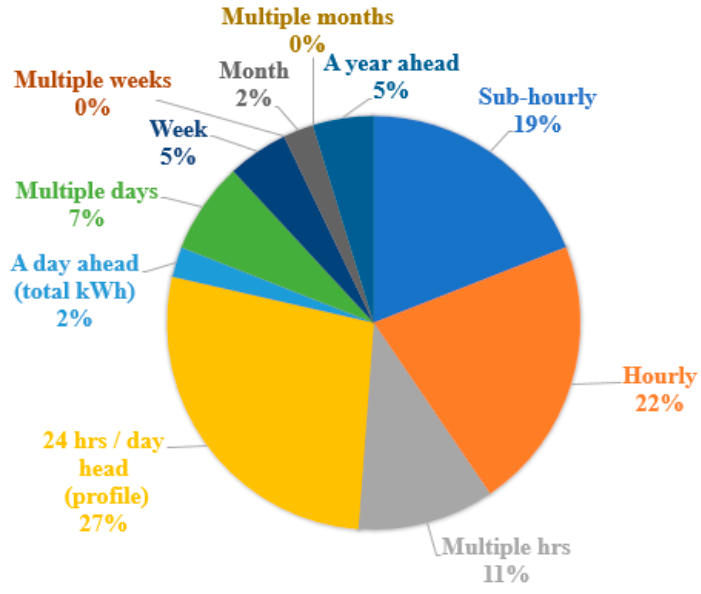
Figure 7. Compositional breakdown of the forecast horizons .